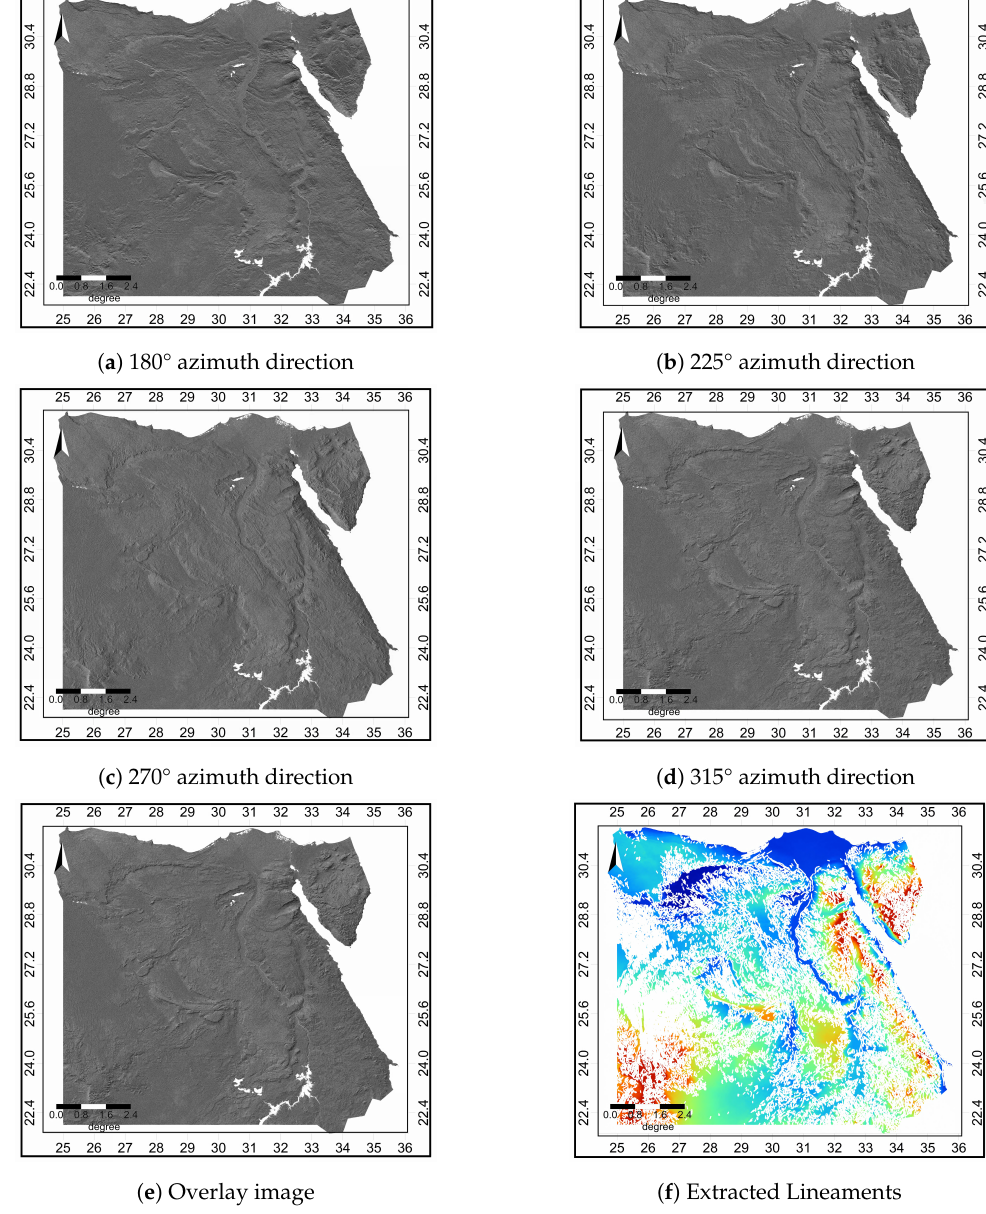
Figure 7. Enhanced shaded-relief images from DEM: ( a ) for azimuth direction of 180°; ( b ) for 225°; ( c ) for 270°; ( d ) for 315°; ( e ) overlay image for automatic lineament mapping, ( f ) automatic extracted